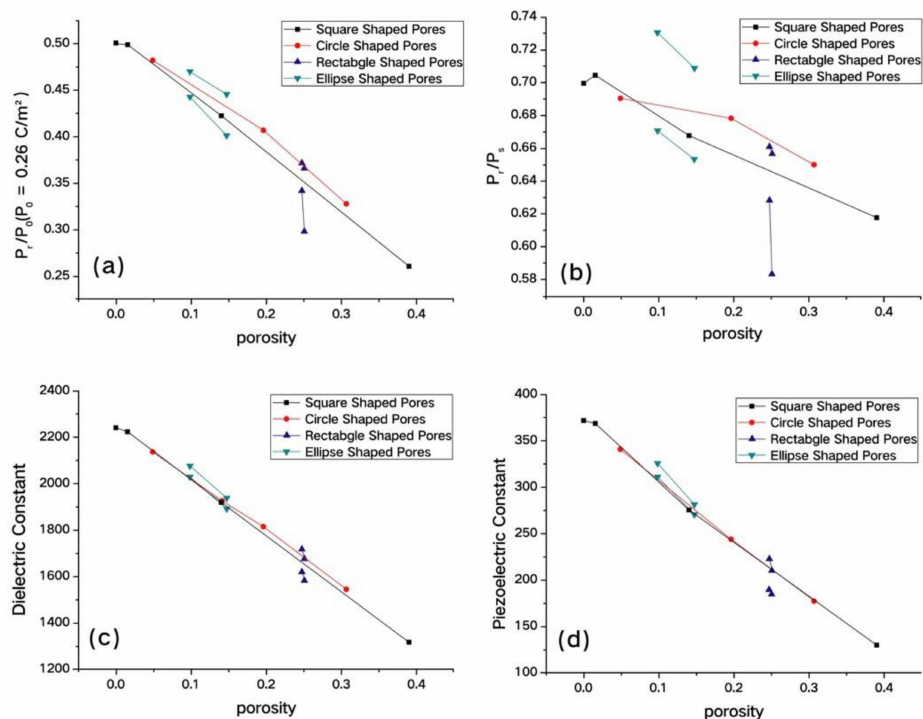
Figure 6. The remnant polarization ( a ) rectangularity factor; ( b ) dielectric constant; ( c ) and piezoelec- tric coefficient; ( d ) versus porosity calculated for various shaped porous ceramics at different porosity levels [111]. Reproduced with permission, Copyright 2012, Acta